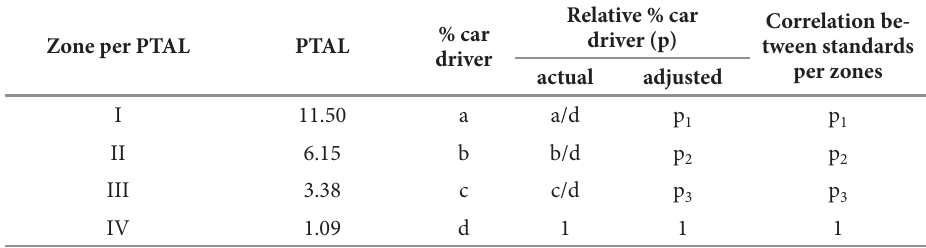
Table 2. Procedure of defining correlation between standards per zones with certain PTAL